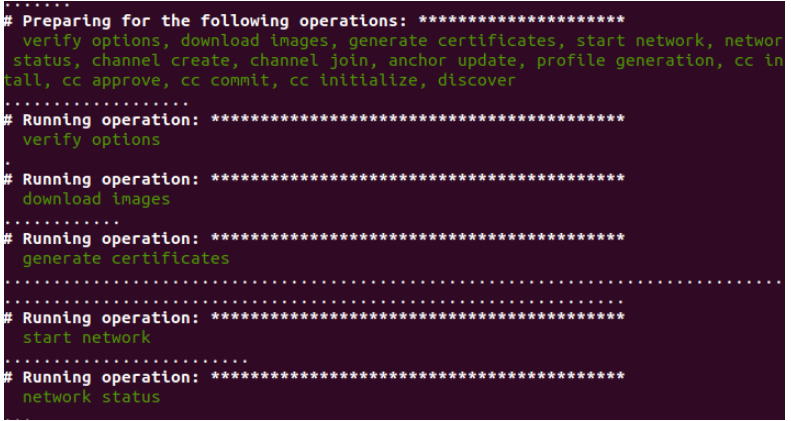
Figure 6. Smart contract operation information.